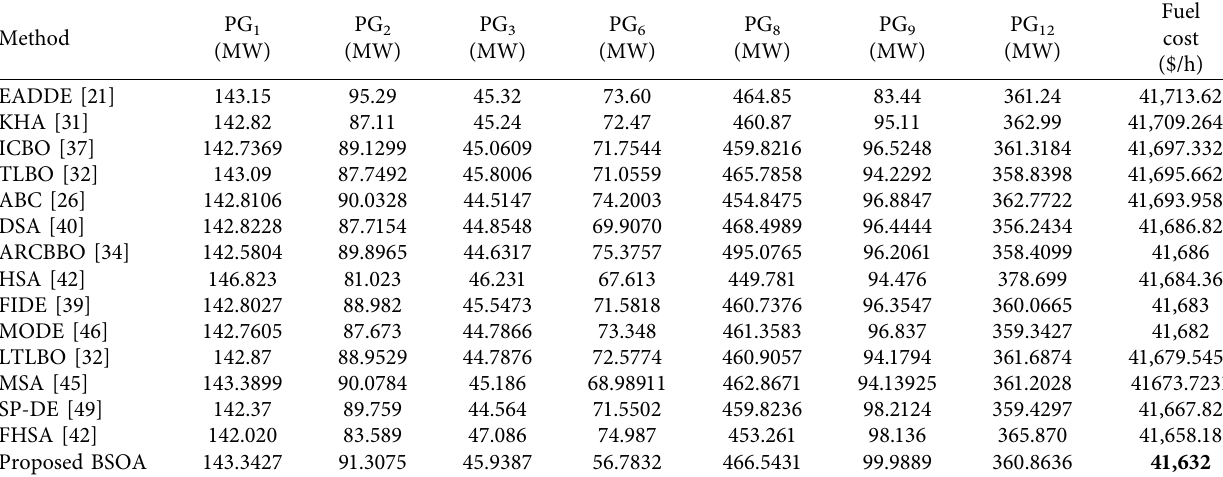
Table 12: Comparison of optimal control variables of generation obtained from diferent recent methods for quadratic fuel cost of the IEEE 57-bus system (Case